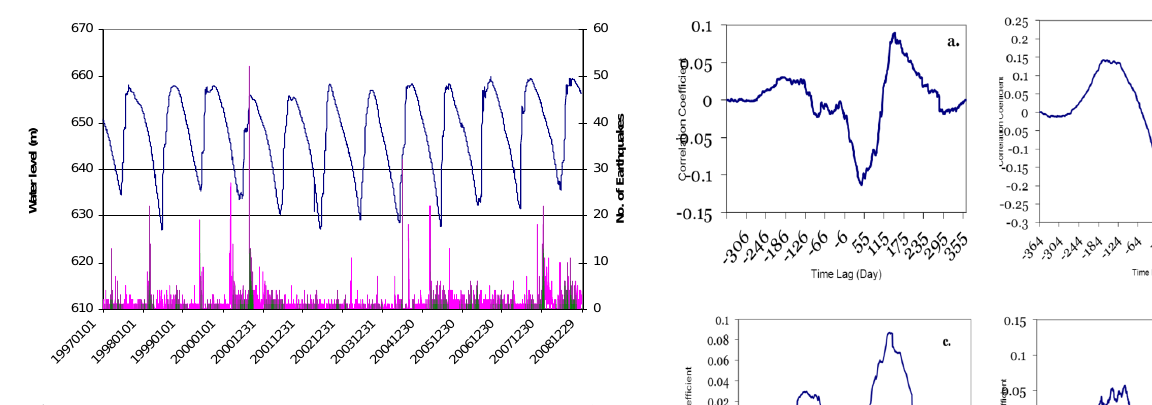
Fig. 3. The Koyna reservoir water levels and the seismicity of the Fig.3. The Koyna reservoir water levels and the seismicity of the region from 1997 to 2008 region from 1997 to 2008.